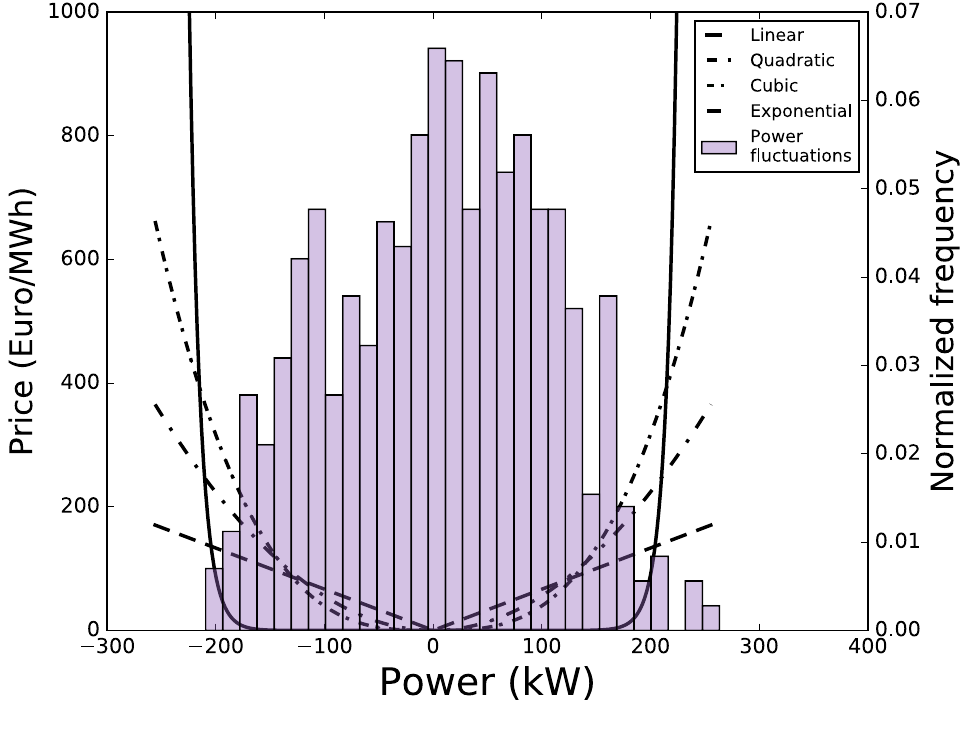
Figure 3. The used cost functions, and the histogram of the power fluctuations at the network point of common coupling